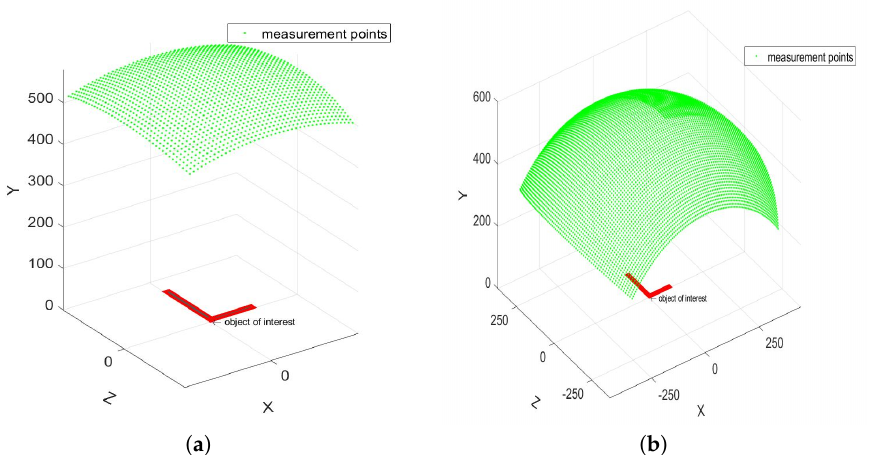
Figure 2. Schematics of the acquisition principles: ( a ) small angle, ( b ) large